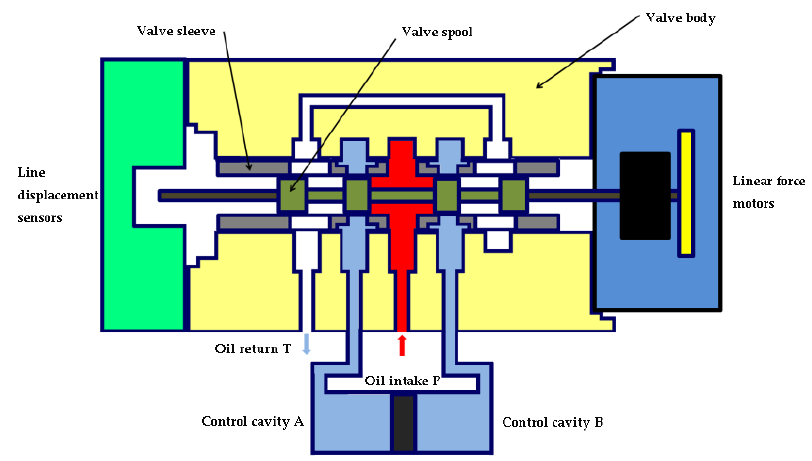
Figure 2. Servo valve zero position state.